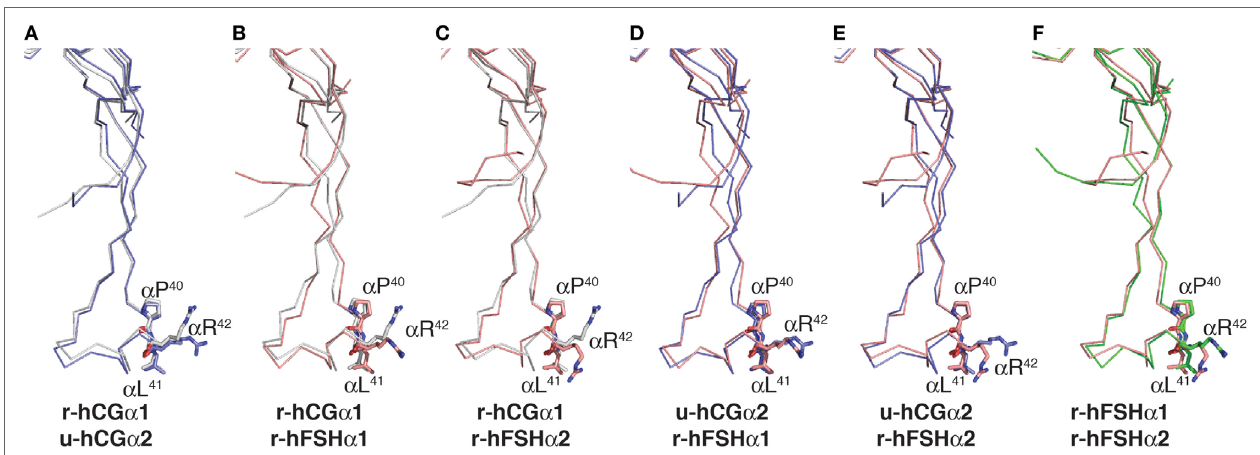
FiGURe 4 | Comparison of Pro-Leu-Arg motif in hCG and follicle-stimulating hormone (FSH) crystal structures. Cystine knot loop α L2 in the common α -subunits from each hormone structure were aligned using MacPyMOL. The backbone traces are shown and the side chains for Pro 40 , Leu 41 , and Arg 42 shown as sticks. The residues are labeled because the flattening effect of printing appears to invert the order of Leu 41 and Arg 42 . Chemically deglycosylated recombinant selenomethionine hCG α is r-hCG α 1 (1hcn), chemically deglycosylated urinary hCG α is u-hCG α 2 (1hrp), recombinant insect cell hFSH (1fl7) resulted in two models identified as r-hFSH α 1 and r-hFSH α 2, respectively. (A–F) α -subunit models aligned as